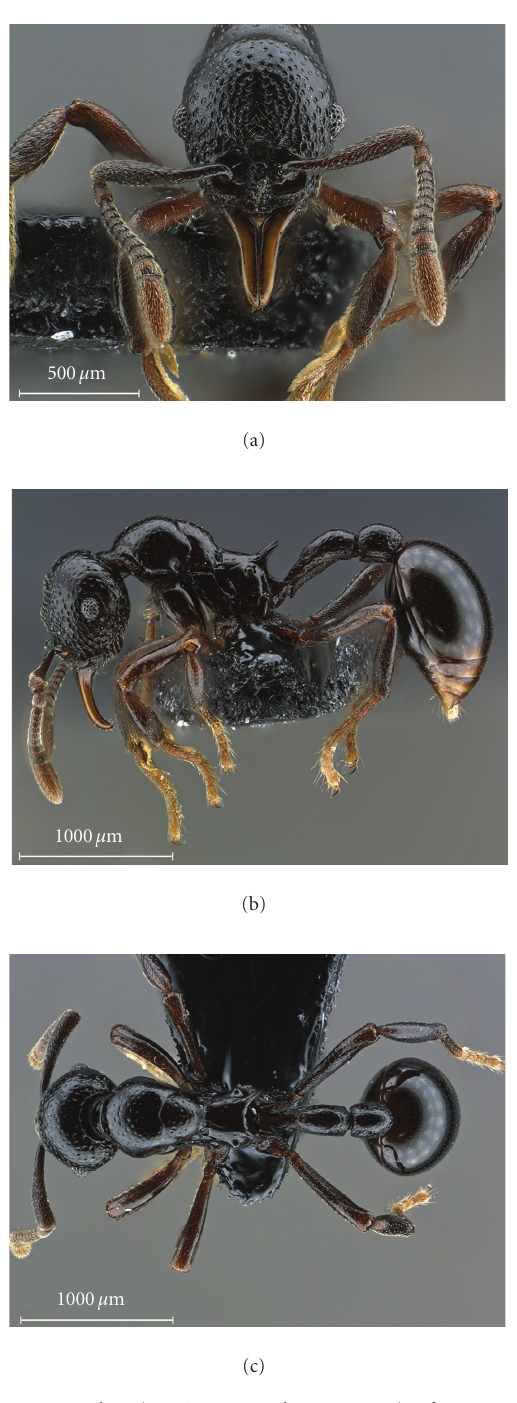
Figure 1: Worker (specimen number 4042619) of Lenomyrmex inusitatus Fern´andez 2001: in (a) frontal, (b) lateral, and (c) dorsal views. Note the predominantly smooth and shiny mesosoma, with no erect hairs (b, c) and the foveolate head, with median longitudinal striae